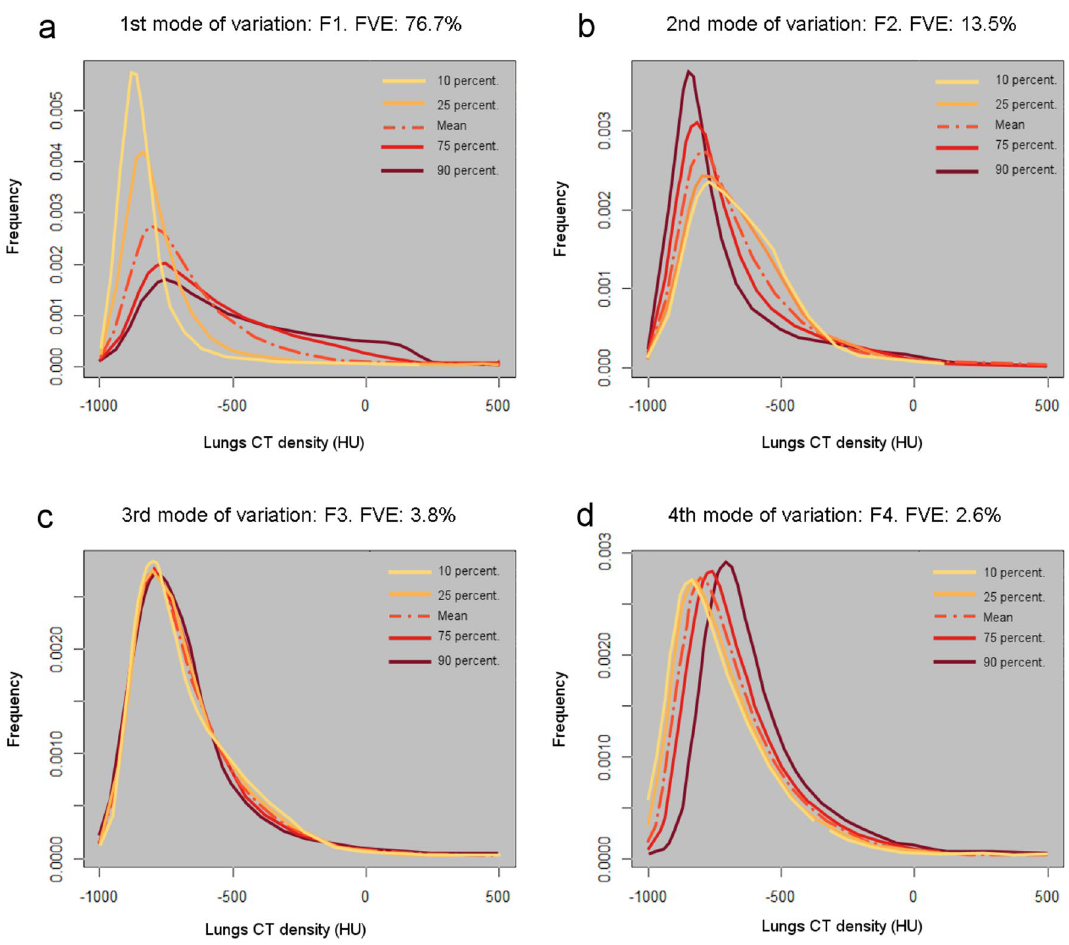
Figure 1. First four modes of variation of the lung CT density curves (smoothed CT histograms). ( a ) F1 explains 76.7% of the fraction of variance explained (FVE). The curves vary from homogeneous low CT density (10 percentile curve) to heterogeneous higher CT density (90 percentile curve). ( b ) F2 explains 13.5% of the FVE. The lung CT density vary from homogeneous low density (90 percentile curve) to include mid-low density in the – 700 HU to – 350 HU range (10 percentile curve). ( c ) F3 explains 3.8% of the FVE. This mode of variation represents a redistribution of CT lung densities from (− 700 HU to – 600 HU) to about (− 600 HU to – 300 HU). ( d ) F4 explains 2.6% of the FVE. F4 represents a small shift of about 140HU from low homogeneous CT densities (10 percentile curve) toward higher CT densities (90 percentile